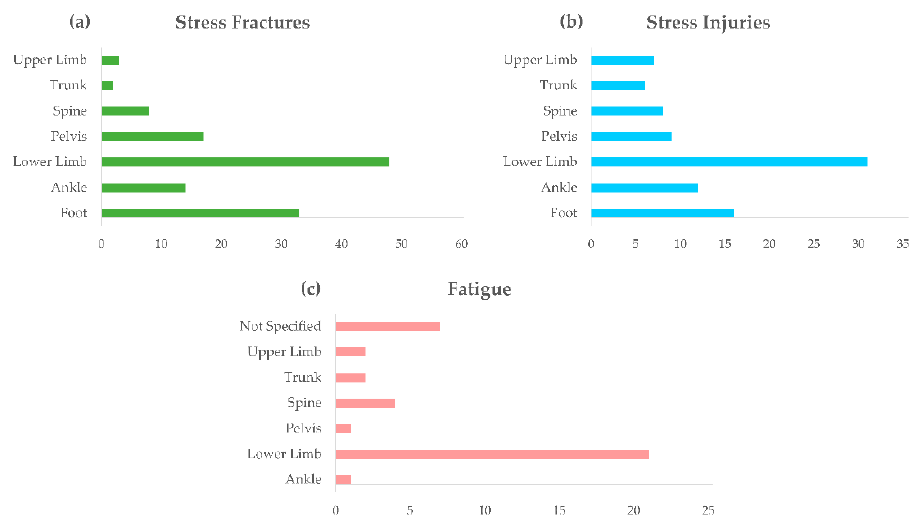
Figure 3. Reviewed articles regarding location of stress fractures ( a ), stress injuries ( b ), and muscular fatigue ( c ).